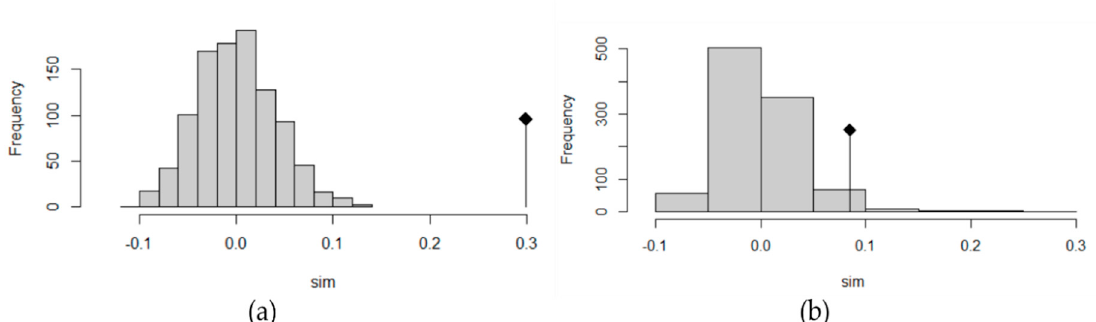
Figure 4. Histograms of the Mantel test assessing the relationship between genetic and geographic distance for Gobius geniporus ( a ) and G. cruentatus ( b ).